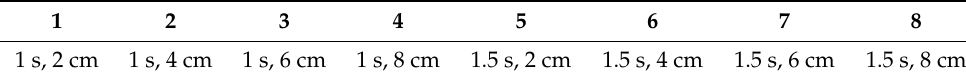
Table 1. Wavemaker settings for the 8 trials of each test series (period, height).